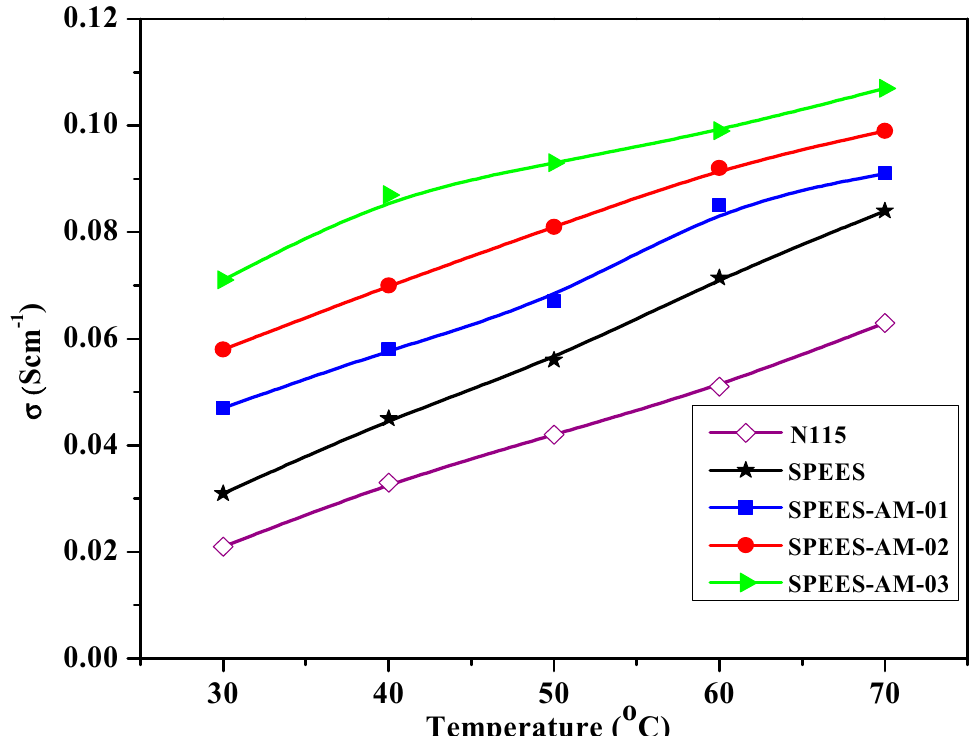
Figure 9. Proton conductivity of Nafion (N115), SPEES and SPEES-AM membranes.